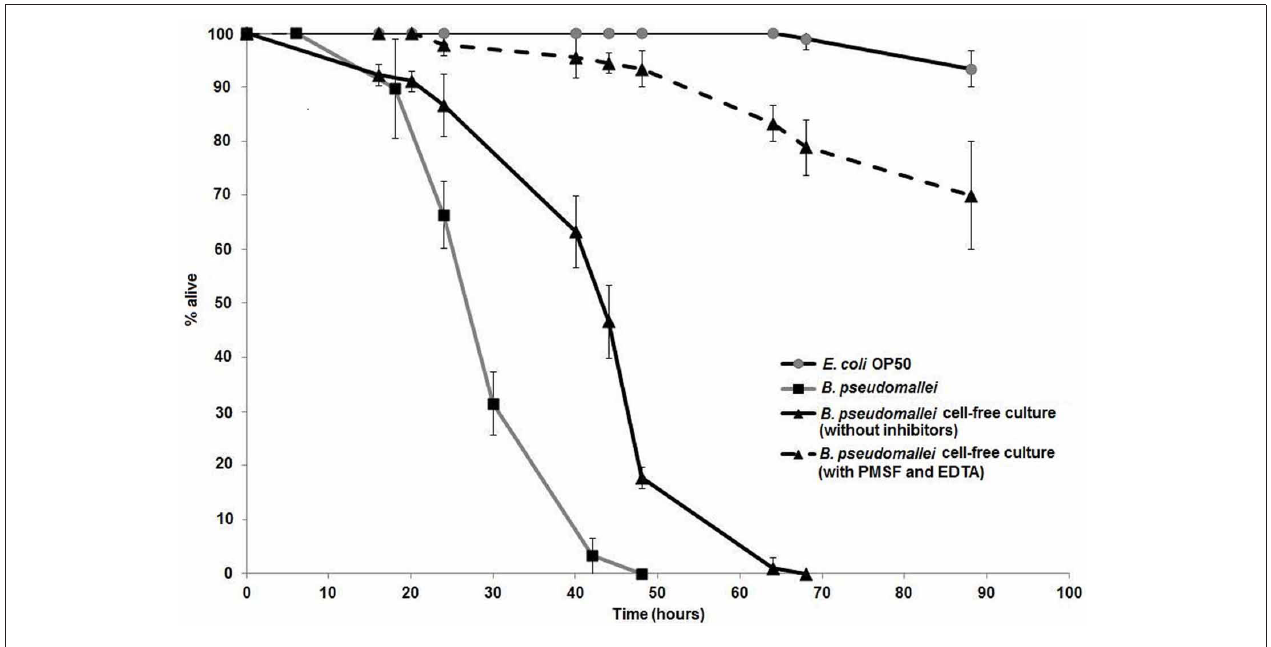
FIGURE 1 | B. pseudomallei proteases contribute toward lethality in C. elegans . One-day old Glp worms were transferred to individual B. pseudomallei cell-free culture without (solid line, black triangles) or with protease inhibitors (PMSF and EDTA) (dashed line, black triangles), E. coli